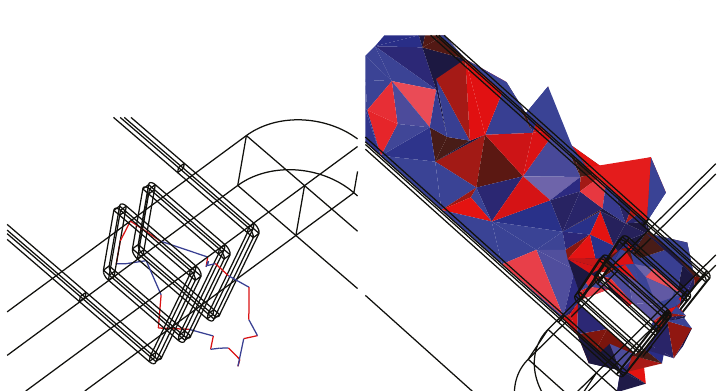
Figure 7: On the left: a representative of the generator of H 1 (cid:6)Ω(cid:7) . On the right, the representative of the generator of H 2 (cid:6)Ω ,∂ Ω(cid:7) .